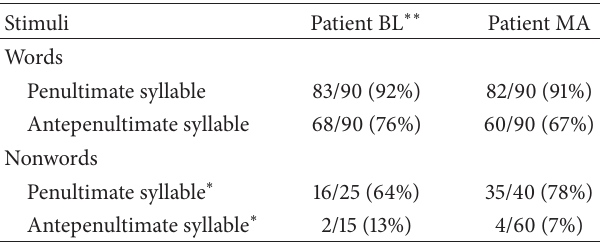
Table 3: Correct responses (%) in reading aloud stimuli with different stress position (Lists 1 and 2 reported in the appendix).